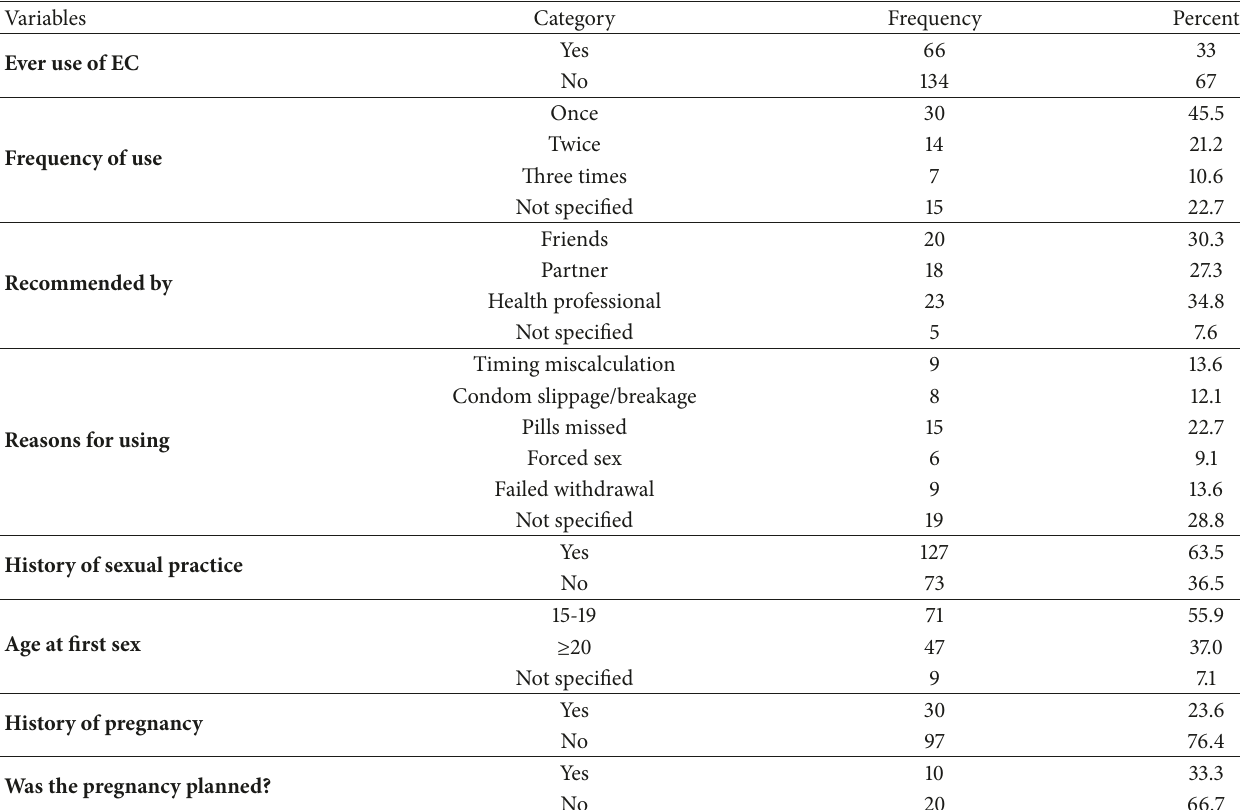
Table 3: Practice of emergency contraception and sexual activity among female college graduating students, Harar, eastern Ethiopia, 2016 (N=200).